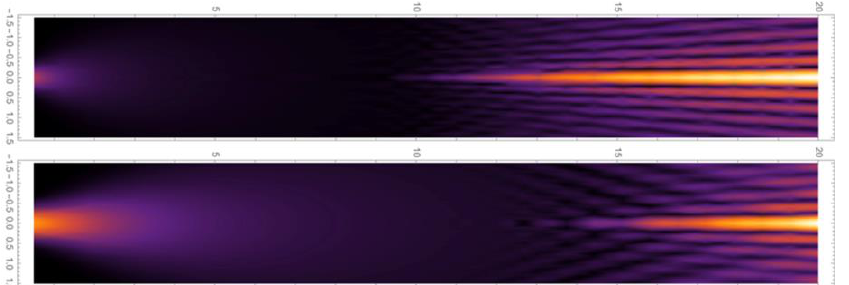
7 Figure 8. Transverse wave amplitude (arbitrary units) as a function of lateral distance from the cen- ter axis for the two cases shown in Figure 7. These are measured at 8 mm range from the transducer and are closely approximated by a Bessel function of zero order.